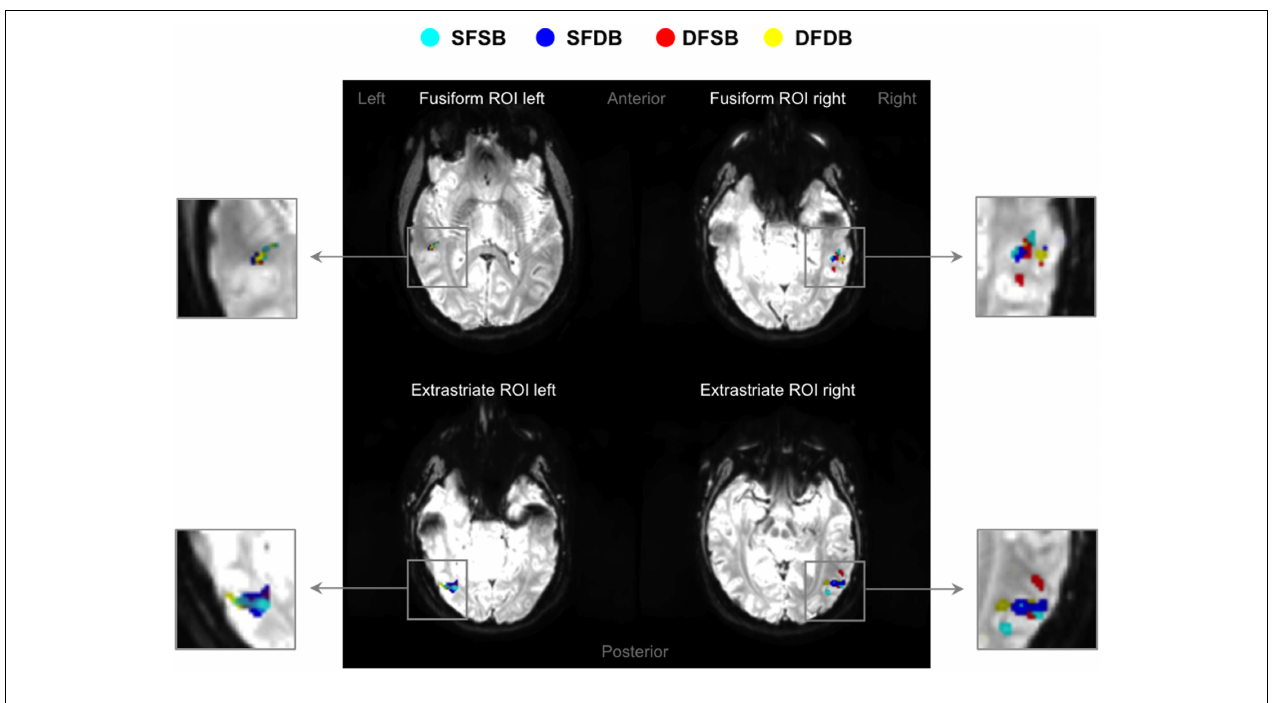
Body (SFDB); (cid:2) : Different Face – Same Body (DFSB); (cid:2) : Different Face – Different Body (DFDB). Contrasts were calculated using t -tests with family-wise error (FWE) corrections for multiple comparisons ( p <